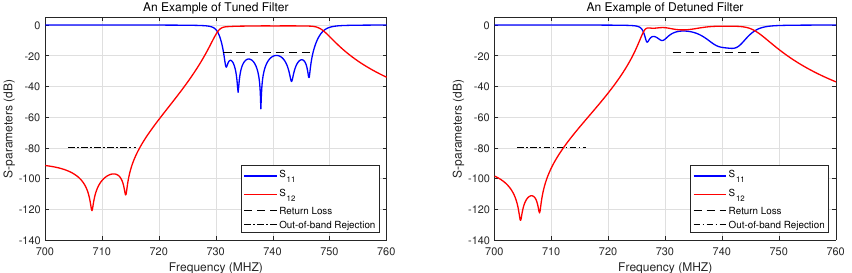
Figure 3. S–parameter curves: the states observed during tuning. In this example, the design specifications require that, within the passband (731 ∼ 747 MHz), the S 11 curve should be less than − 18 dB (Return Loss), and the S − 2 db (Insertion Loss). For the 12 curve should be no less than Out-Of-Band Rejection, it requires that the S 12 curve should be less than − 80 dB within the range (704 ∼ 716 MHz). These are the targets for cavity filter